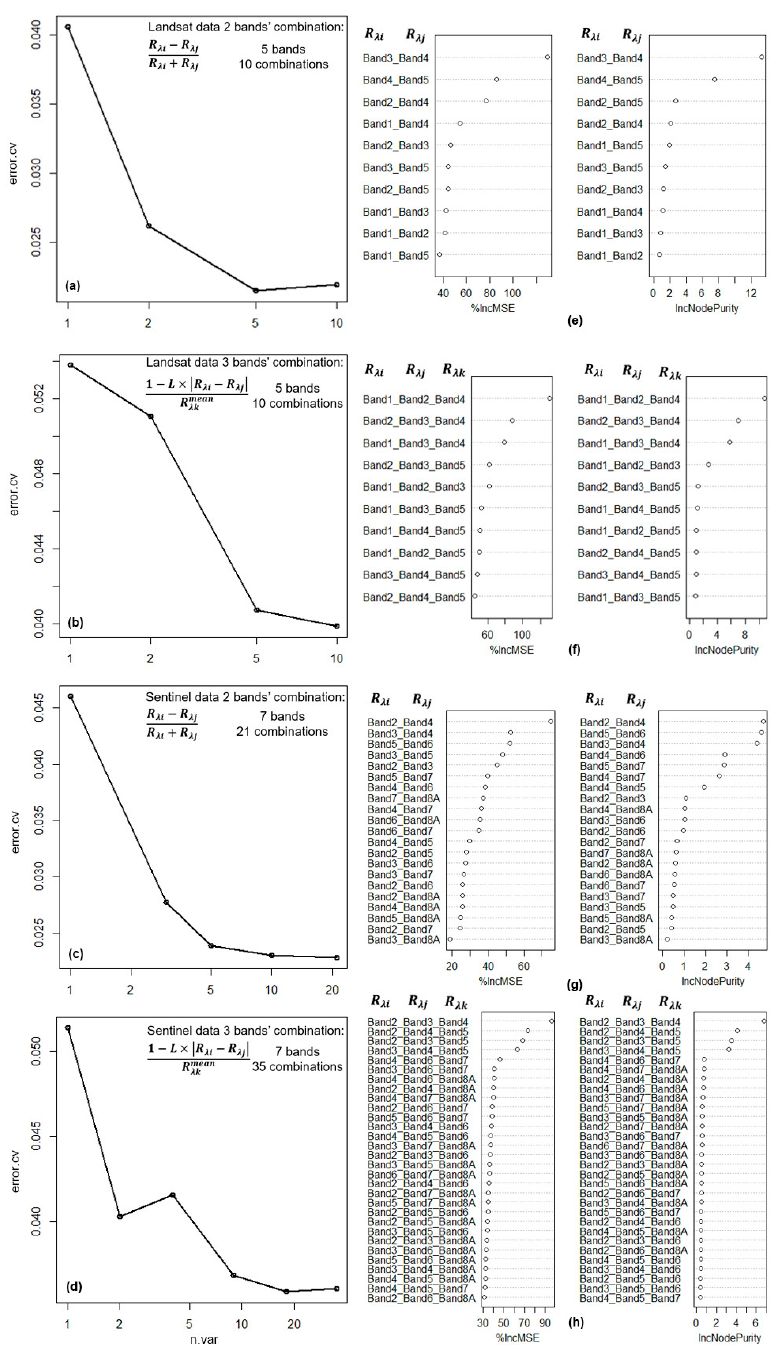
Figure 6. Variable selection of random forest (RF) models for the simulated multispectral data of ( a , e ) Landsat channel with band combinations based on Crust Index (CI); ( b , f ) Landsat channel with band combinations based on Biological Soil Crust Index (BSCI); ( c , g ) Sentinel channel with band combinations based on CI; ( d , h ) Sentinel channel with band combinations based on BSCI. n.var is the vector of number of variables used in each step; “error.cv” is the corresponding vector of mean square errors (MSEs) in each step; %IncMSE is the standard deviation of the difference between MSE for each tree and MSE after permuting each predictor variable and then averaging over all trees; IncNodePurity is the residual sum of squares from the total decrease in node impurities from splitting of variable and then averaged over all trees. BandX_BandY means Band X combined with BandY (see more details of Band number in Table